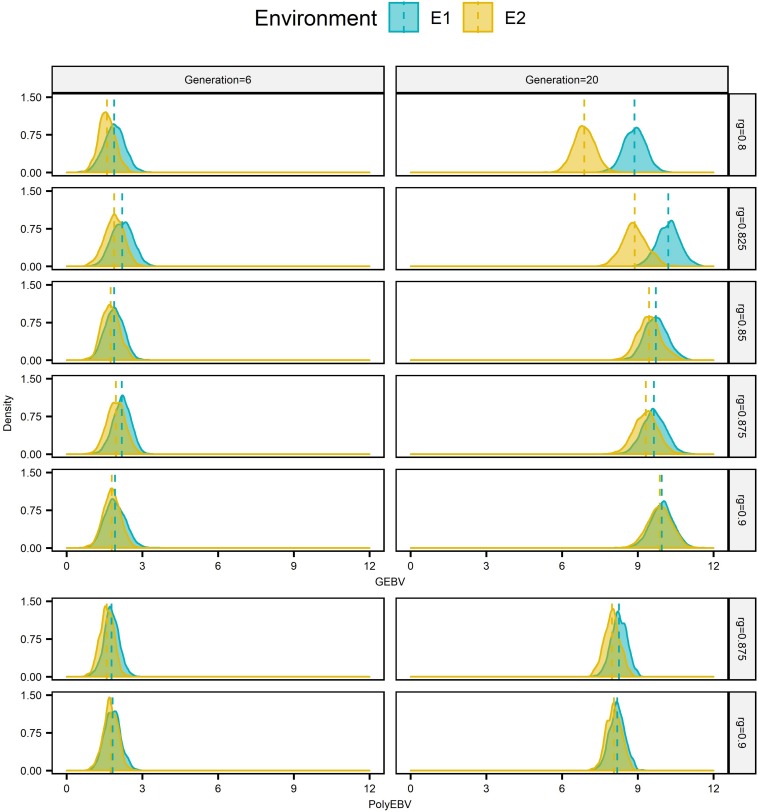
Distributions of EBV of male candidates from two sources1 at generation 6 and 20 for E12 based on one single randomly selected replicate for EPS3 situation for scenario AG-AS4 and AP-AS4 (h2 = 0.3). 1Candidates from E1 and E2 are in blue and in yellow, respectively. 2E1/E2 refers to environment 1/environment 2.  3EPS refers to the situation that two environments had equal population sizes (1000:1000). 4AG-AS, scenario of across-environment genomic evaluation and across-environment selection for sires; AP-AS, scenario of across-environment pedigree-based evaluation and across-environment selection for sires. Vertical dashed lines mark distribution means.